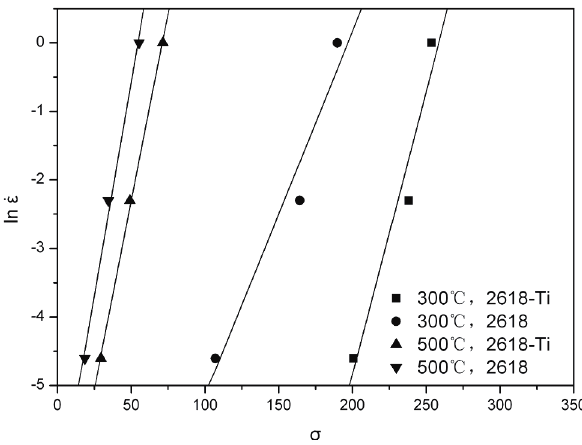
Fig. 8: Relationship of ln ε  and σ for alloy 2618 and 2618-Ti